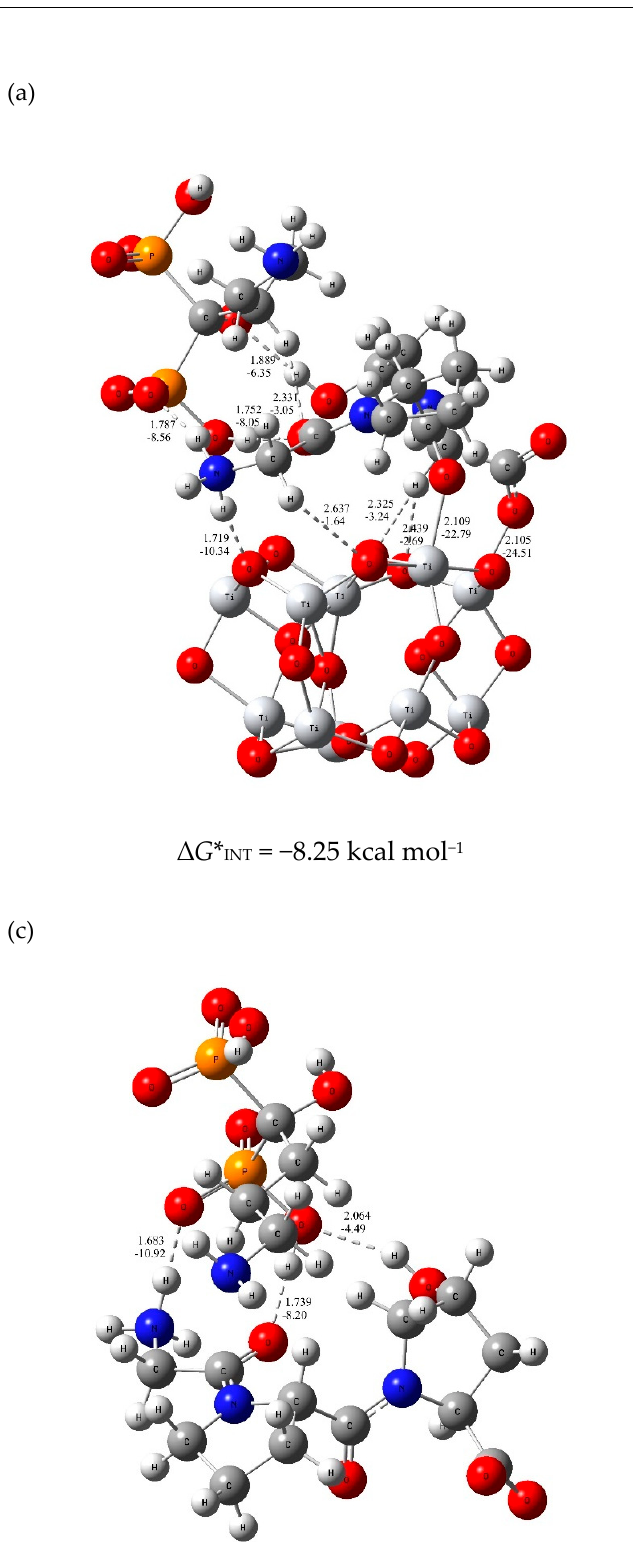
2 ) 10 –alendronate–tripeptide,